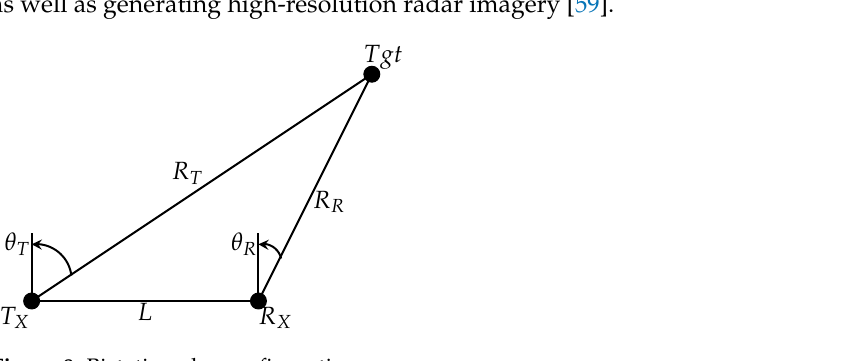
Figure 8. Bistatic radar configuration.